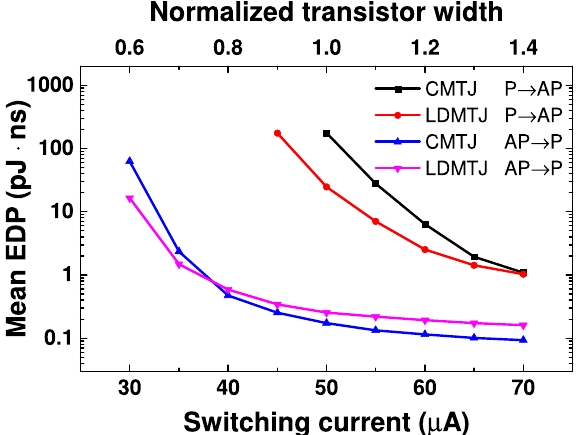
Figure 5. Mean energy-delay product of the CMTJ and LDMTJ devices. Each point on the plot is averaged over 1000 simulations. Top axis shows the effective transistor width normalized to the width required to maintain the current of 50